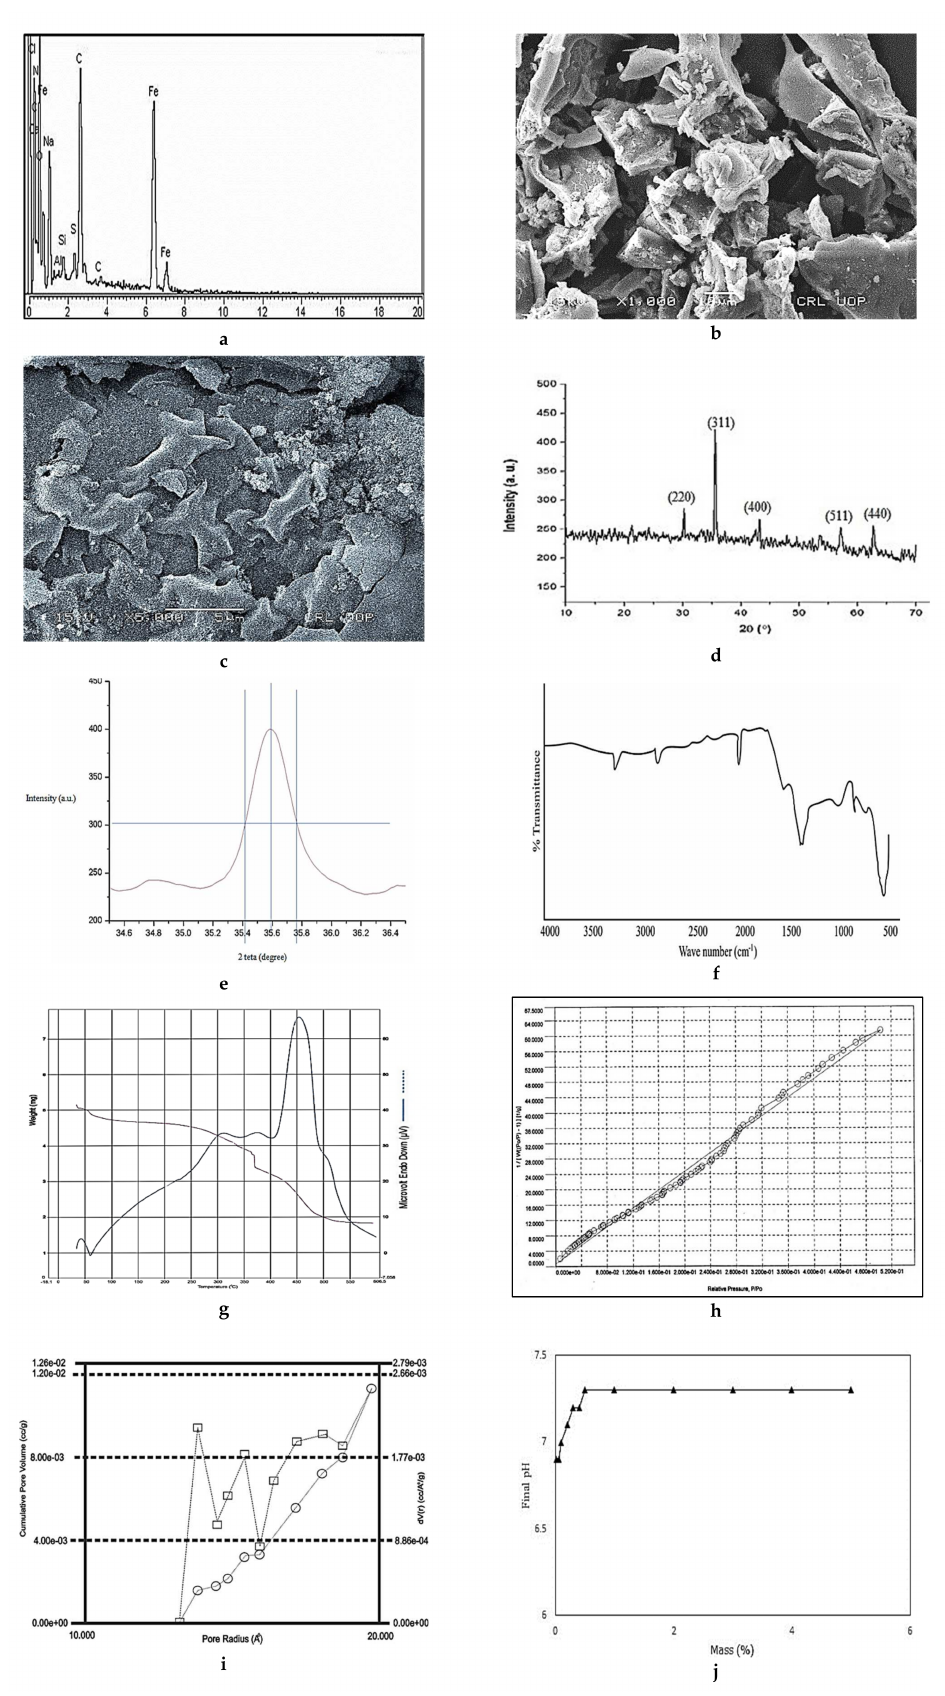
Figure 2. Characterization of Fe 3 O 4 /C ( a ) EDX ( b ) and ( c ) SEM ( d ) XRD ( e ) FTIR ( f ) Debye–Scherrer plot ( g ) TG/DTA ( h ) BET plot ( i ) BJH plot ( j )